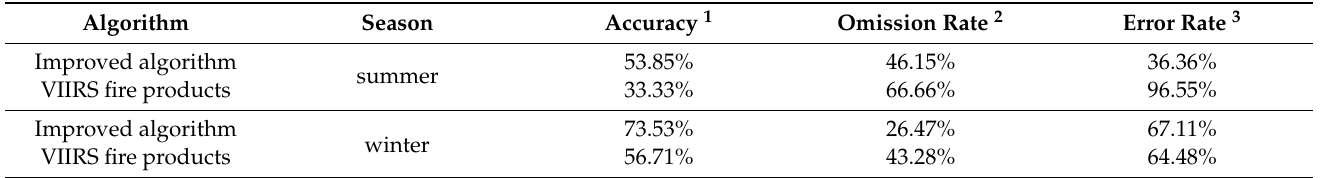
Figure 5. Map displaying sites of manual fire validation in eastern China in winter (Red) and summer (Orange). Table 2. Comparison of algorithm